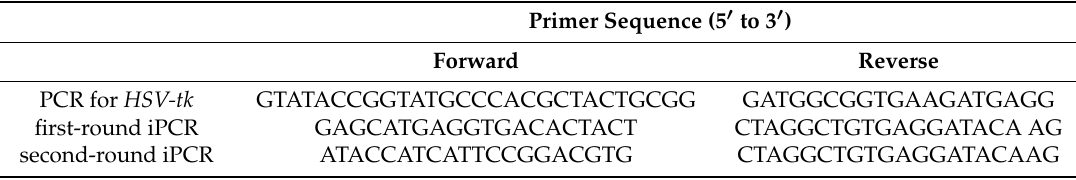
Table 1. Sequences for primers used by PCR and iPCR. Primer Sequence (5 (cid:48) to 3 (cid:48)